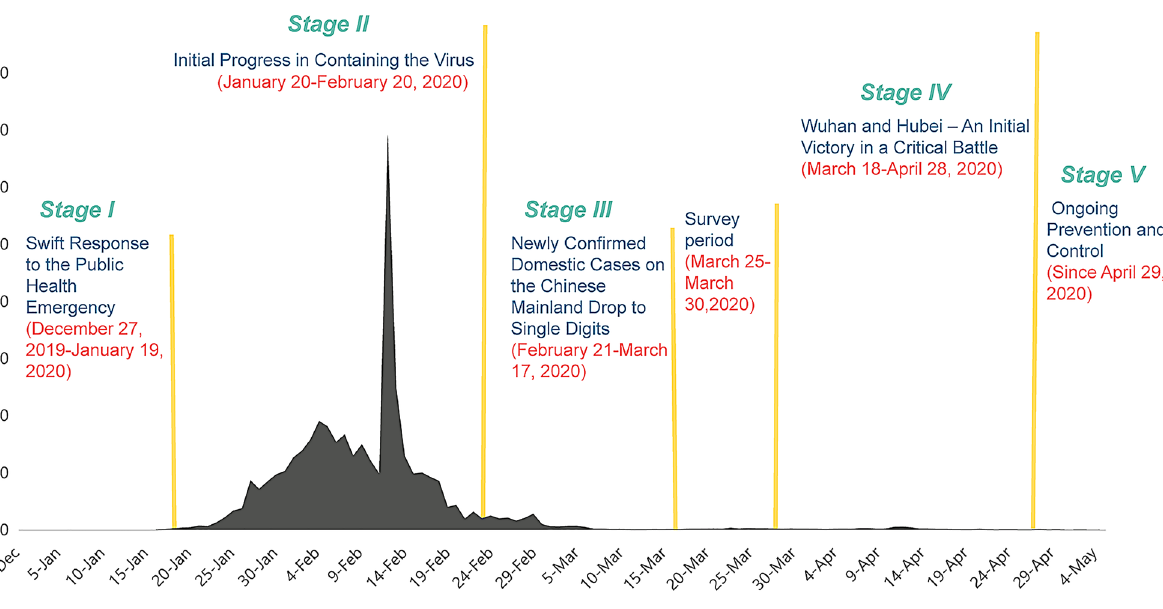
Figure 1. Daily figures for newly confirmed cases in Mainland China (from January 3 to May 5, 2020; Data sources: World Health Organization Situation Reports 49 ) and stages of China’s fight against the epidemic (sources: Fighting Covid-19 China in Action 55